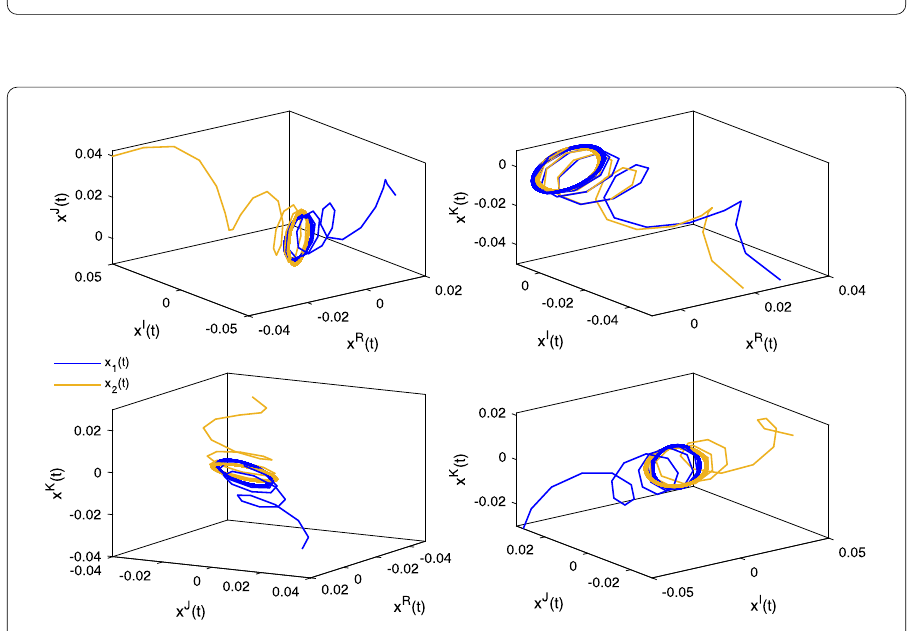
Figure 5 Curves of x R 2 ( t ), x I 2 ( t ), x J 2 ( t ) and x K 2 ( t ) in three-dimensional space for stable